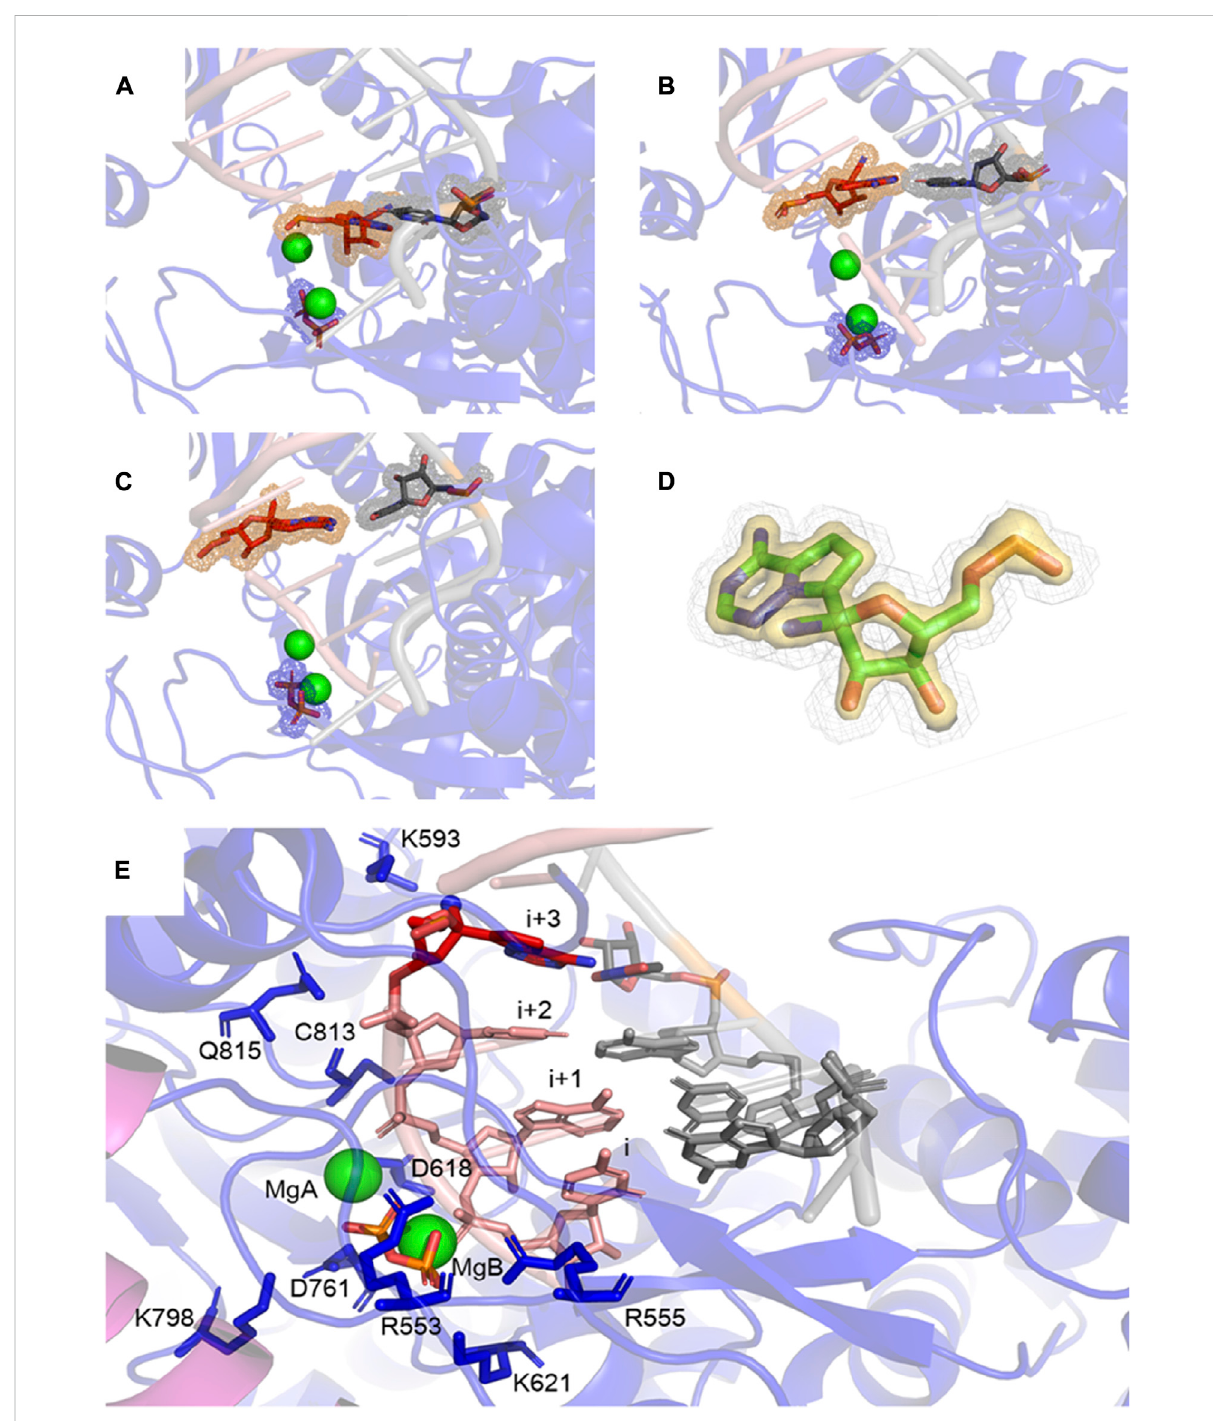
MD-derived ED maps. (A – C) MD-derived ED maps carved for the PPi and the ( i + 1), ( i + 2), and ( i + 3) base pairs inthe context ofRNA duplexes. The electron densities for PPi, RMP and U which form Watson-Crick interactions are shown in mesh. (D) Close-up view of the MD-derived ED maps carved for the RMP in two contour levels (low contour level in silver mesh and high contour level in gold surface). (E) Close-up view of RMP at i +3 complex. PPi, ( i + 1), ( i + 2), and ( i + 3) base pairs and surrounding residues are shown in sticks. Mg 2+ ions are shown in